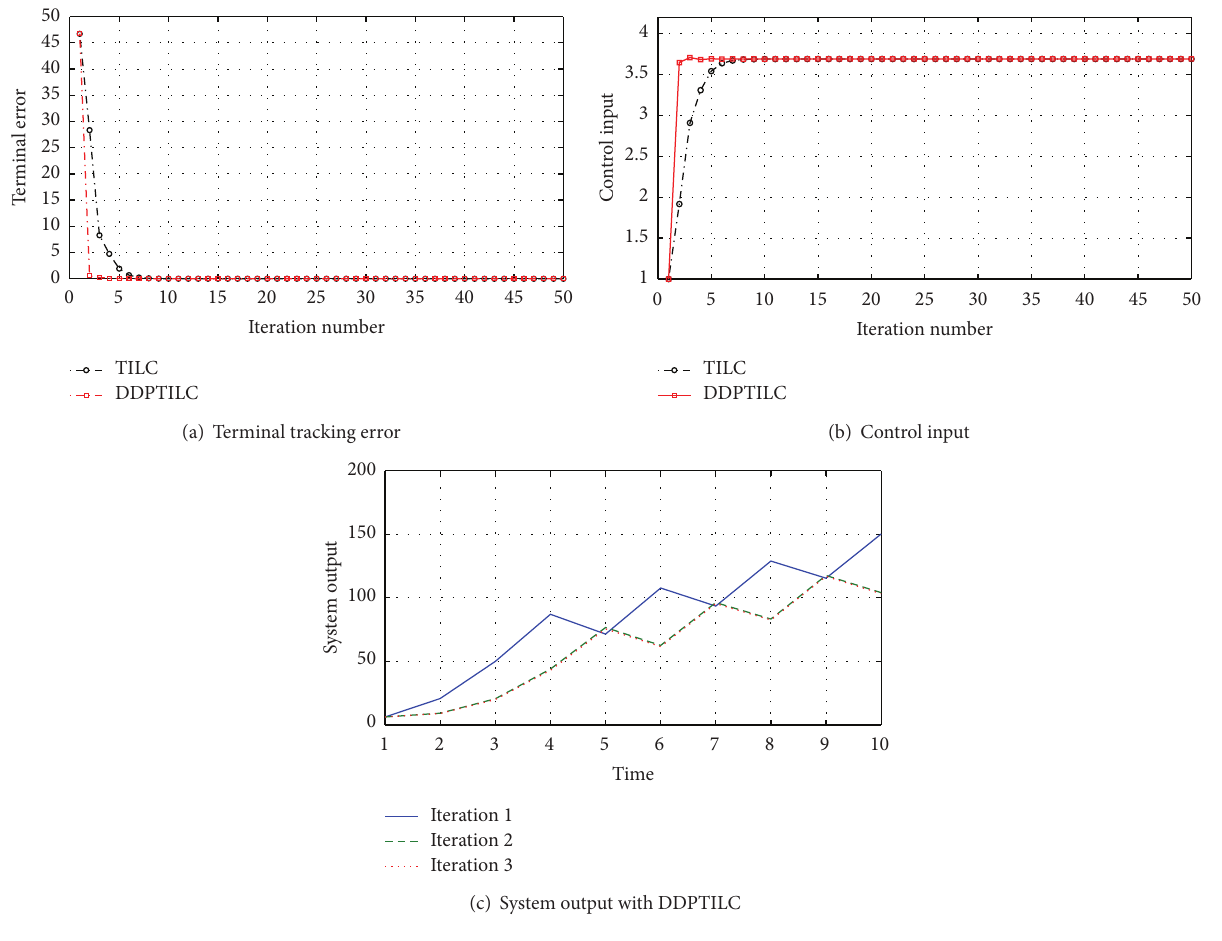
Figure 1: Simulation comparison between TILC and DDPTILC (Case